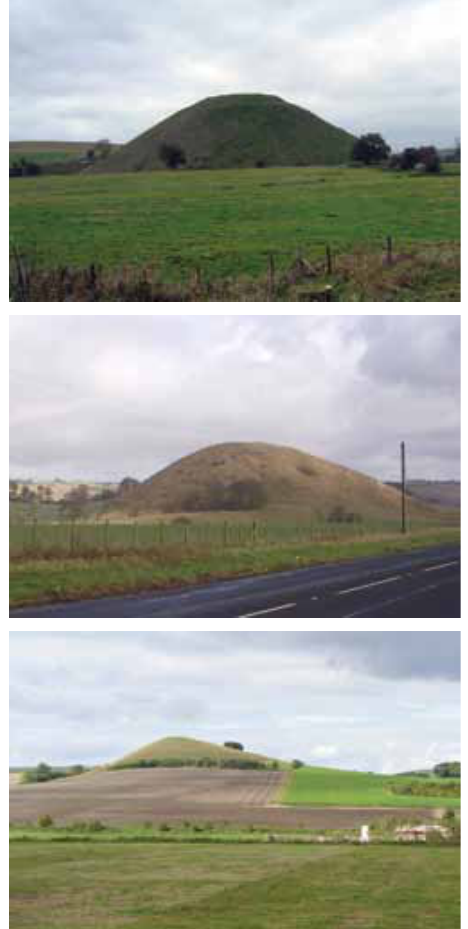
Fig. 2: Locating Anglo-Saxon meeting-places: several meeting-places are located in close proximity to such distinctive hills as Silbury Hill, Wiltshire (top), Summerhouse Hill, Kent (centre), and Picked Hill,